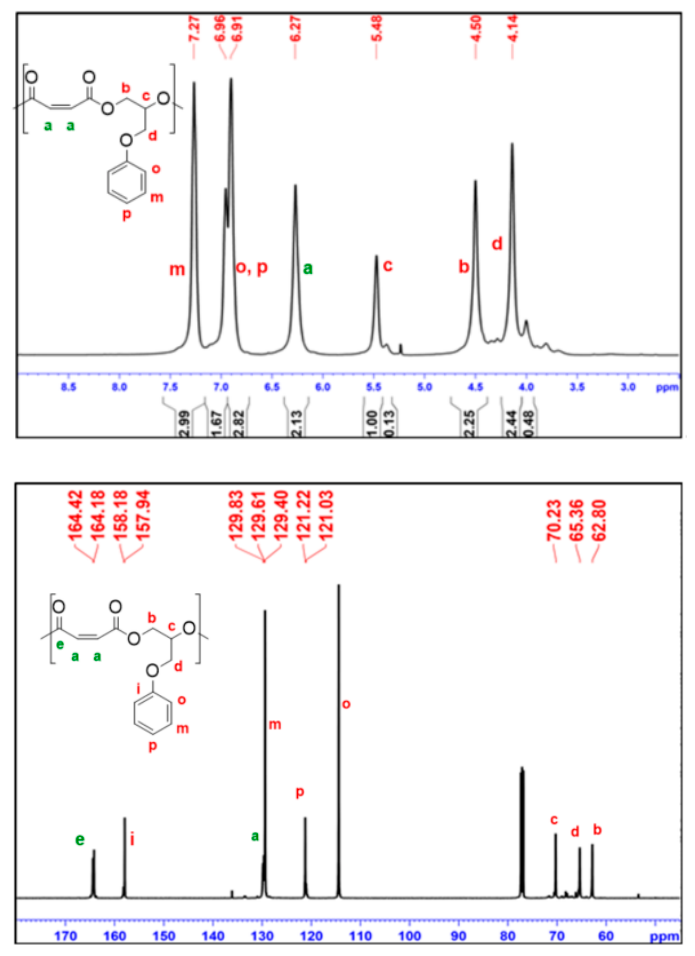
Figure 1. 1 H (top) and 13 C NMR (bottom) spectra of the polyester obtained from the reaction between phenyl glycidyl ether (PGE) and MA in the presence of cat- 1